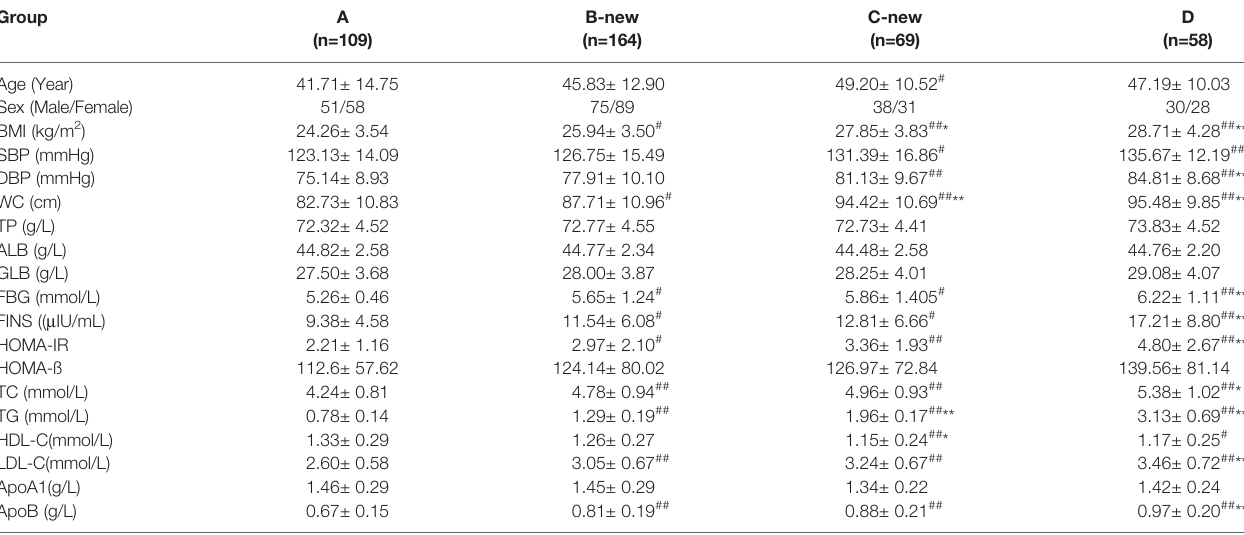
TABLE 3 | Basic parameters of groups of different FTG concentration.